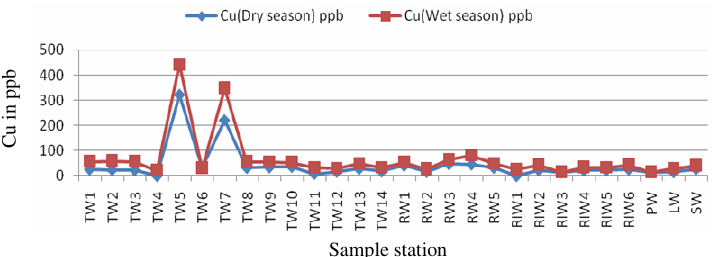
Figure 4. Seasonal variations of Cu(ppb) in the study area